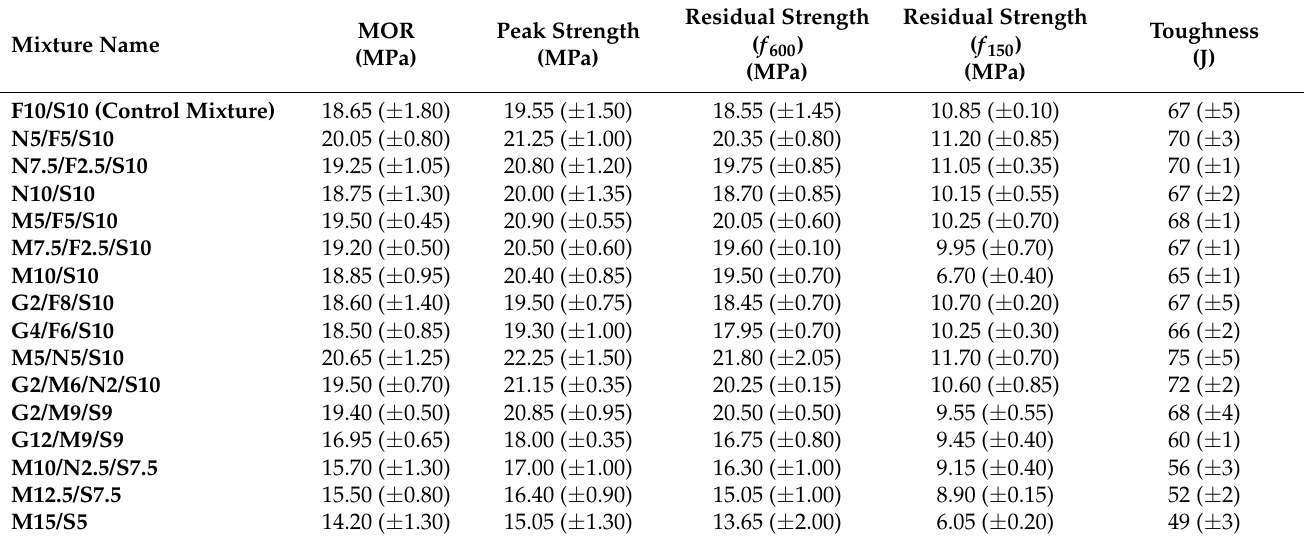
Table 4. Flexural strength results ( ± standard